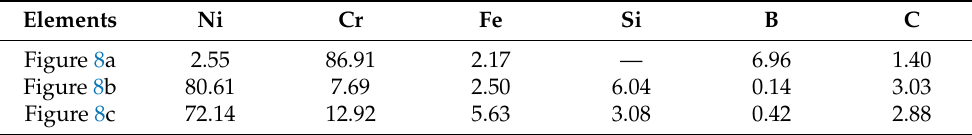
Table 2. Chemical compositions corresponding to Figure 8